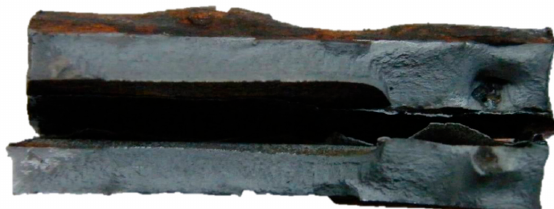
Metals 2021 , 11 , x FOR PEER REVIEW Figure 11. Fracture zone of the joint 766-FM-C. Figure 11. Fracture zone of the joint 766-FM-C.